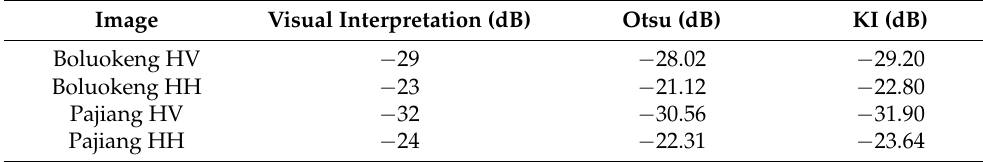
Table 4. The comparison of thresholds using different threshold segmentation methods.